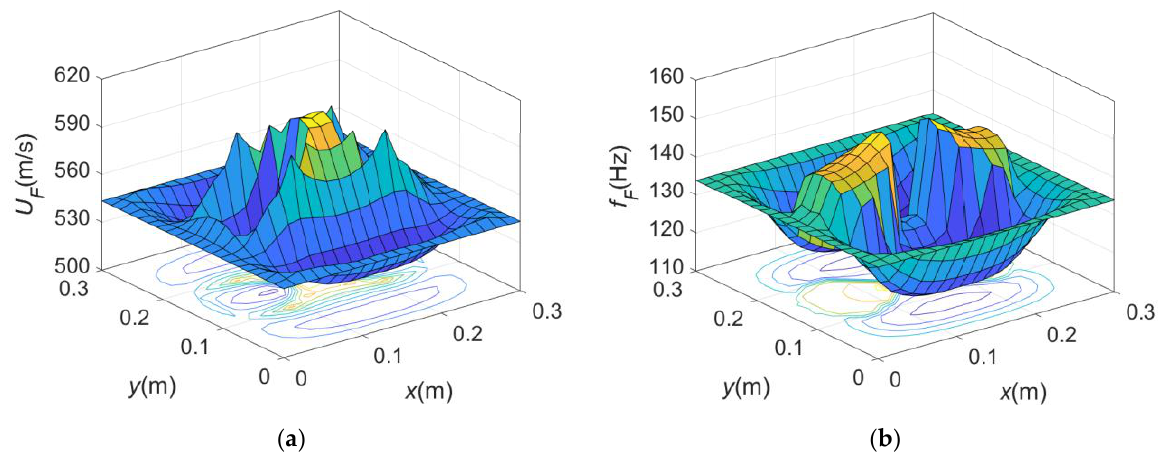
Figure 9. The changes in the flutter characteristics of the panel with the location ( x , y ) of the mass